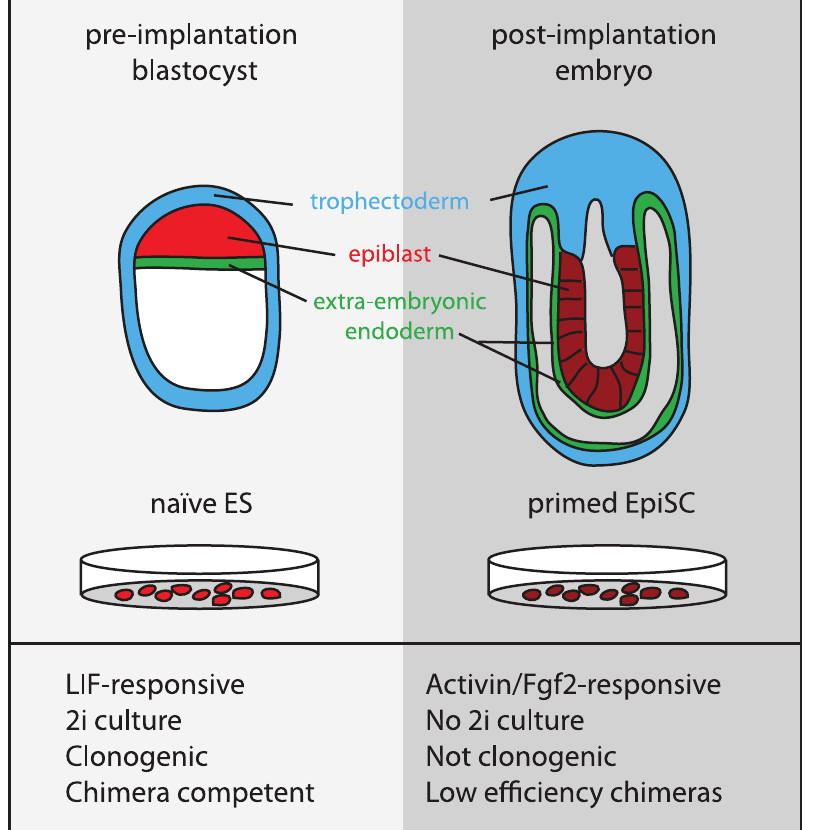
Figure 1. The origin and properties of naı¨ve and primed pluriopotent stem cells.